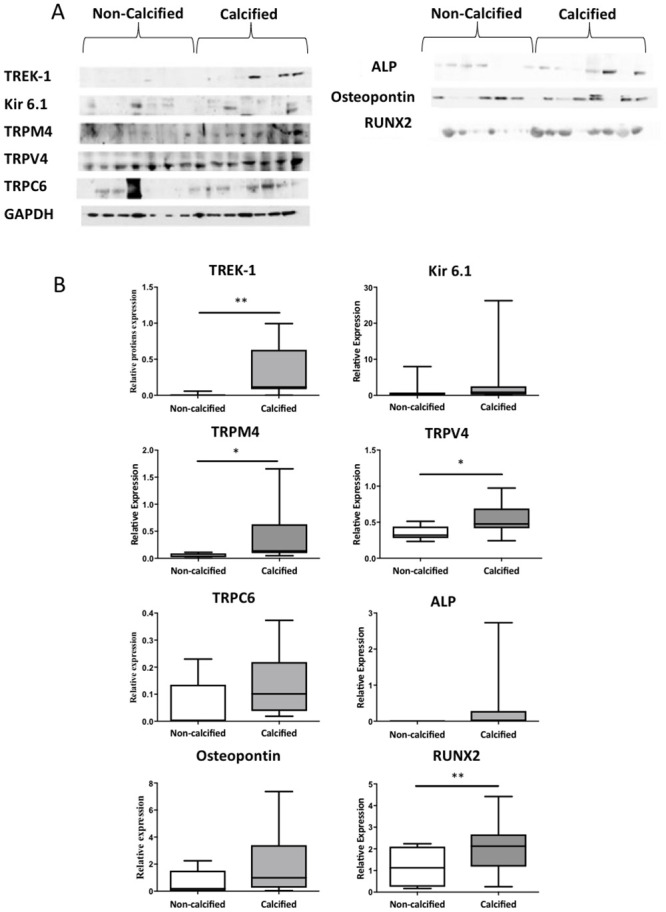
Protein expression of mechanosensitive ion channels in non-calcified and calcified aortic valve tissue from patients.A: Western blots showing expression of various MSC, and of markers of calcification in cusp tissue from calcified and non-calcified valves. B: Quantification of relative expression of individual channel proteins and calcification markers in non-calcified and calcified valves (n = 6 patients; * = p<0.05, ** = p<0.01).